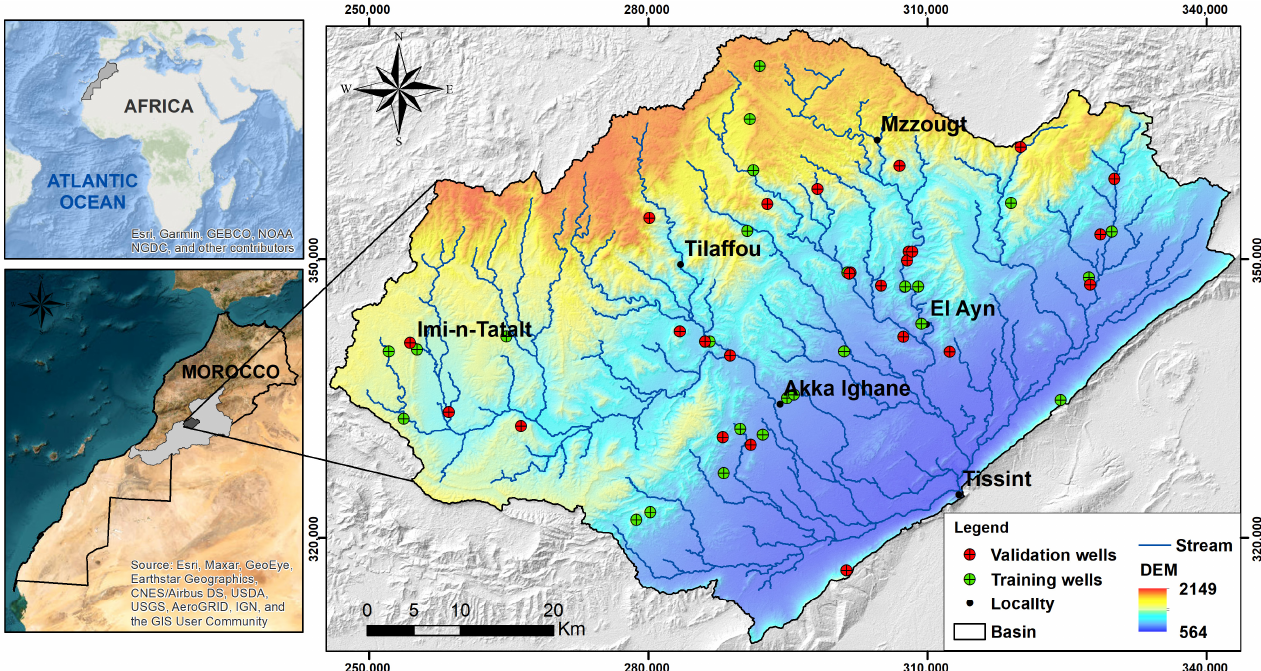
Figure 1. Tissent basin location with the Digital Elevation Model (DEM).